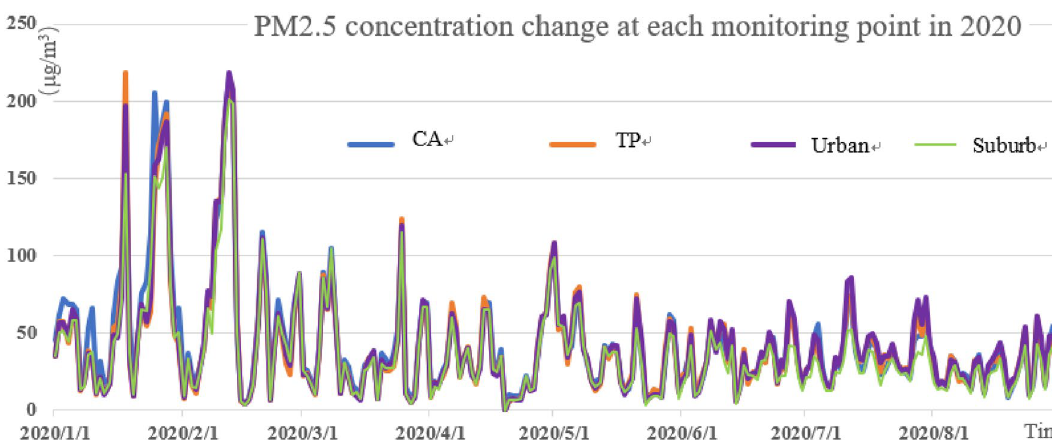
Figure 5. PM 2.5 concentration changes at all monitoring points in 2020.